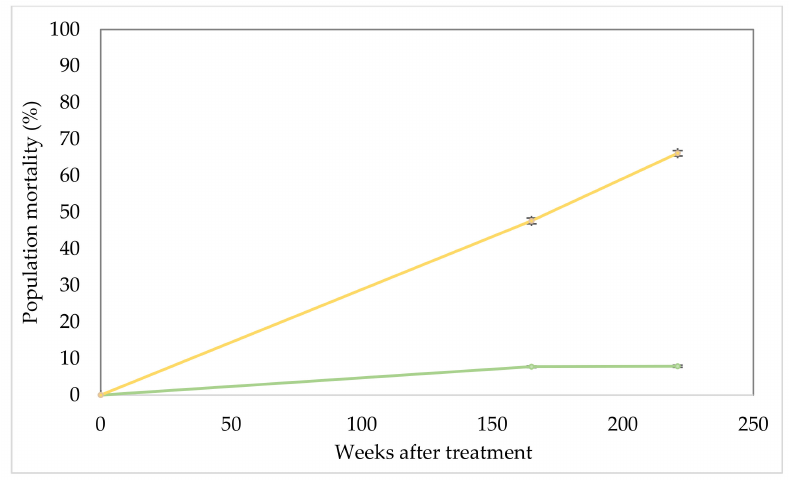
Figure 7. South parkinsonia infestation mortality over trial duration (0, 165 and 221 WAT). Treated plants (gold), untreated control plants (green). Error bars represent ± standard error of means.